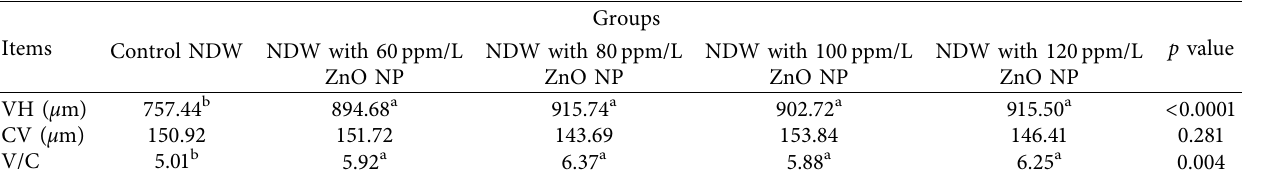
Table 7: Efect of zinc oxide nanoparticles (ZnO NPs) on duodenum morphology of broilers at 42 days of age. Items